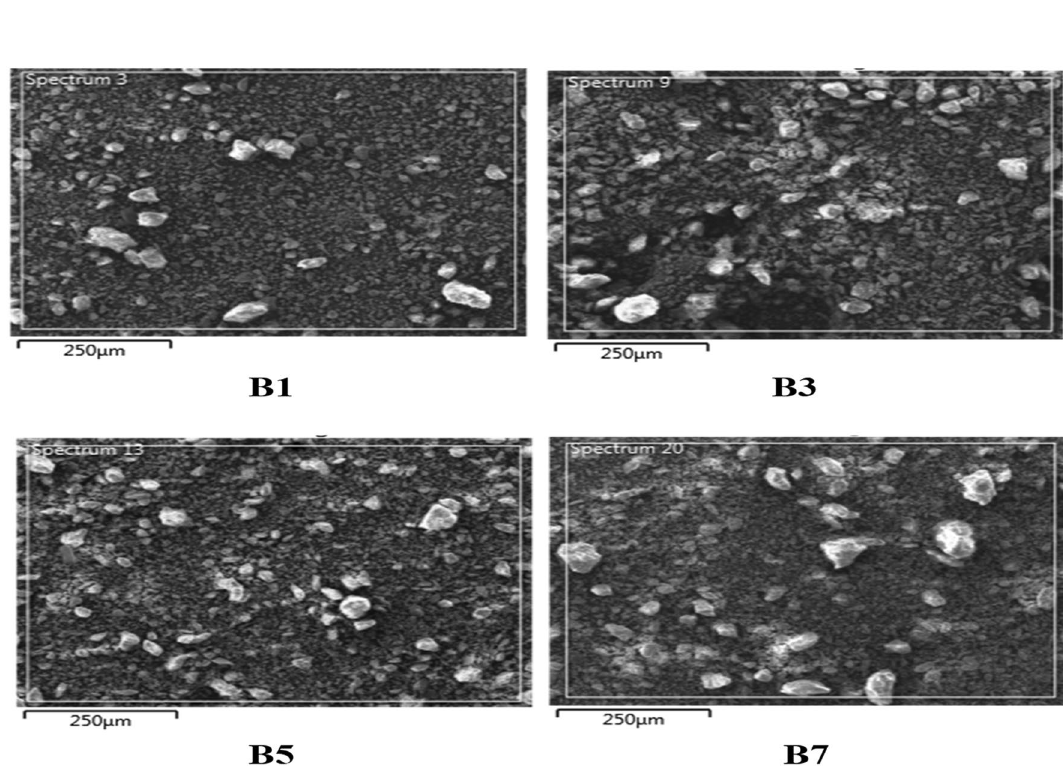
Fig. 3 SEM images of selected samples from various